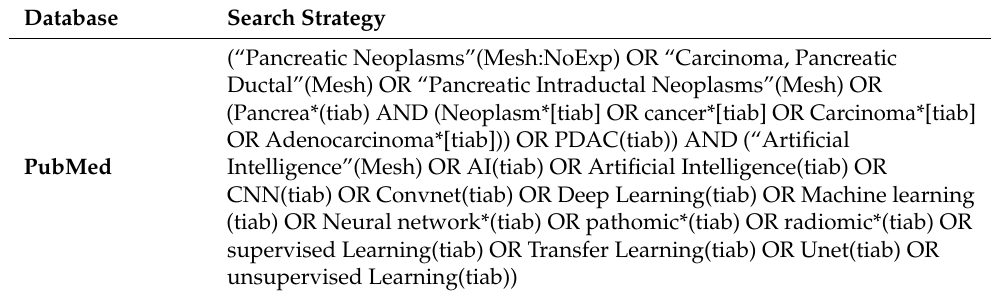
Table A1. Search strategy. MeSH terms and keywords for the included